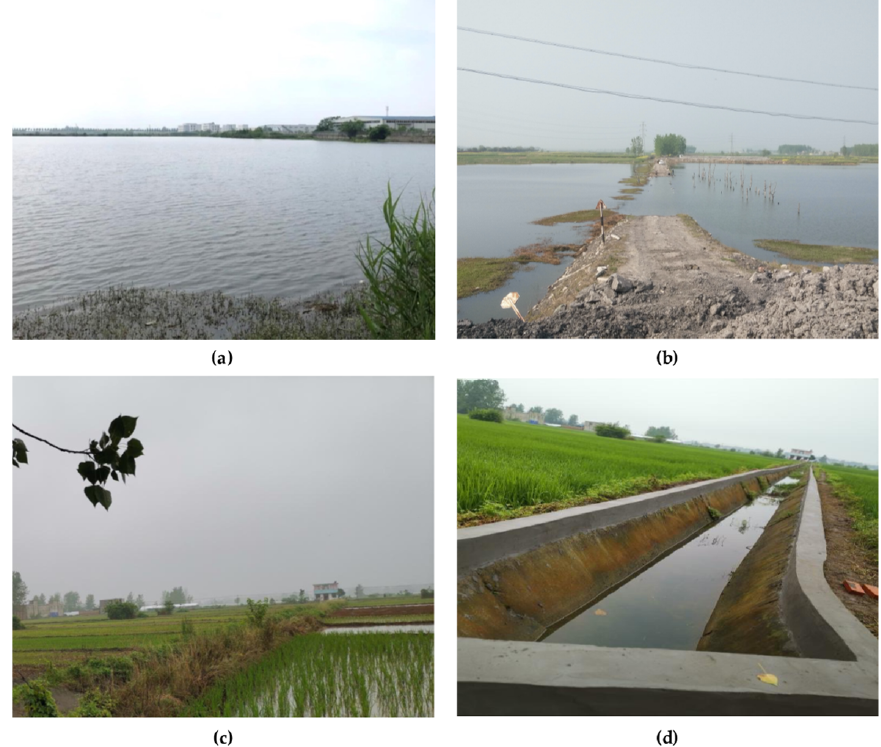
Figure 3. Ecological environment status of subsidence area. ( a ) Current situation of subsidence water; ( b ) a road caused by subsidence; ( c ) farmland irrigation before restoration; ( d ) farmland irrigation after restoration. Source: Figures are from the studied coal mining